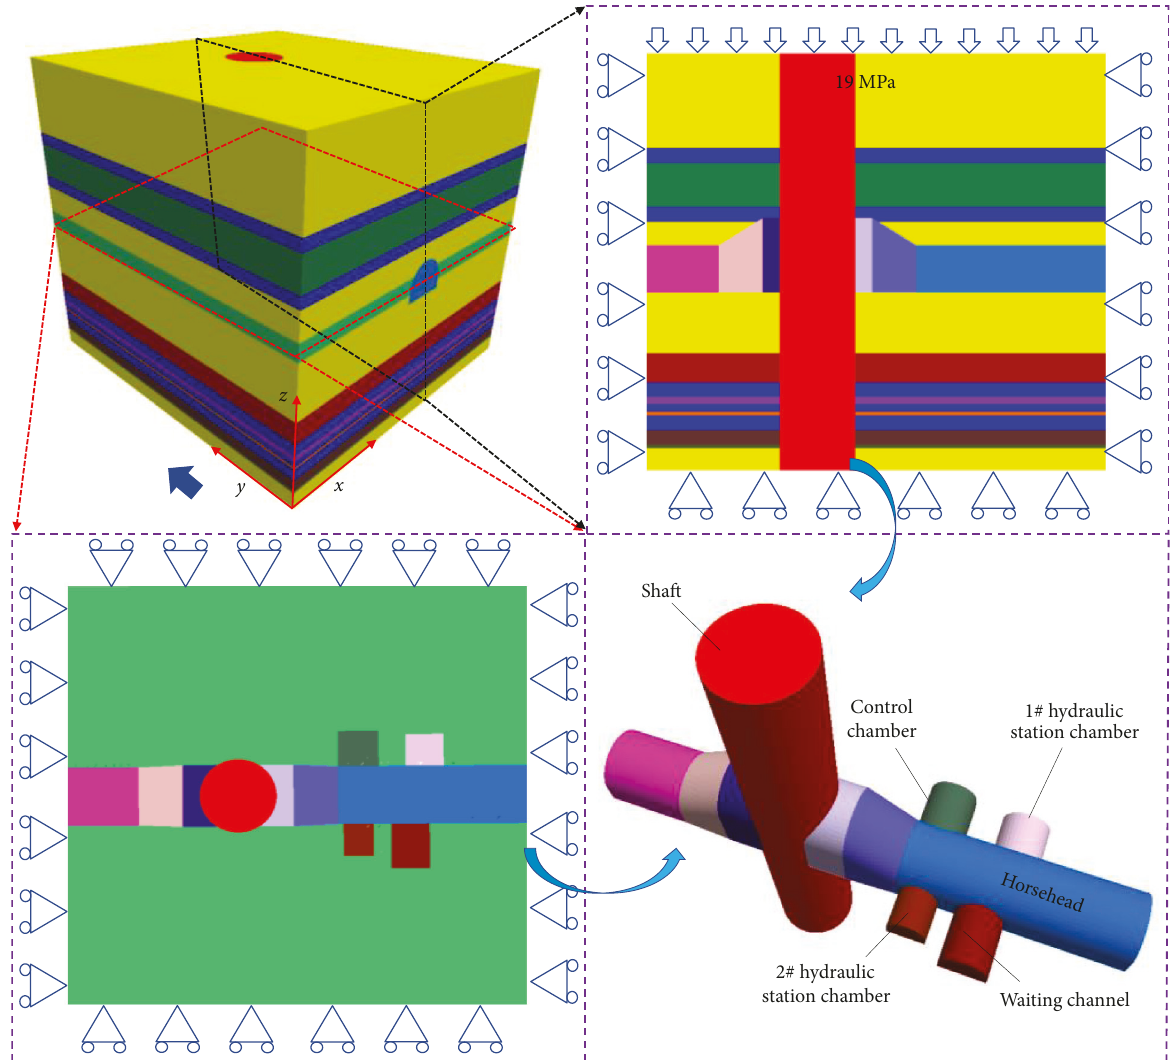
Figure 5: Numerical calculation